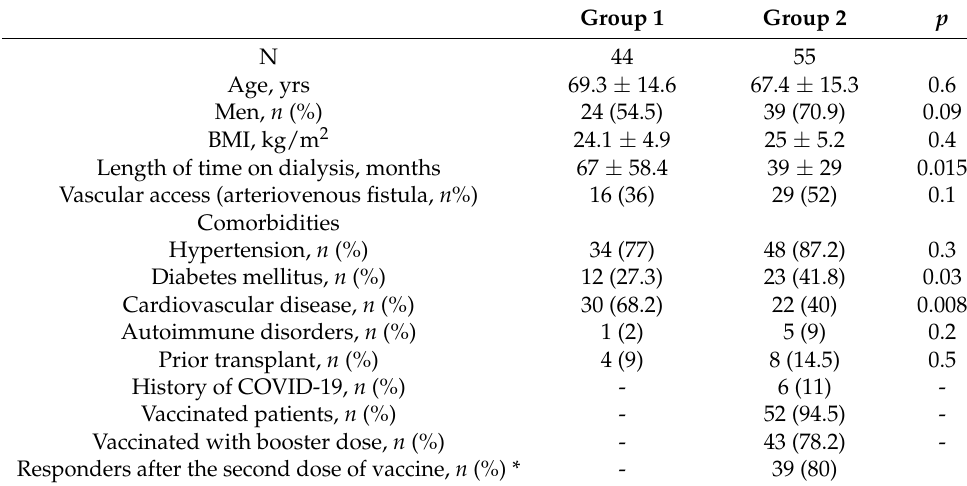
Table 1. Demographics and medical history at admission of hemodialysis patients affected by COVID-19 during the different periods evaluated.